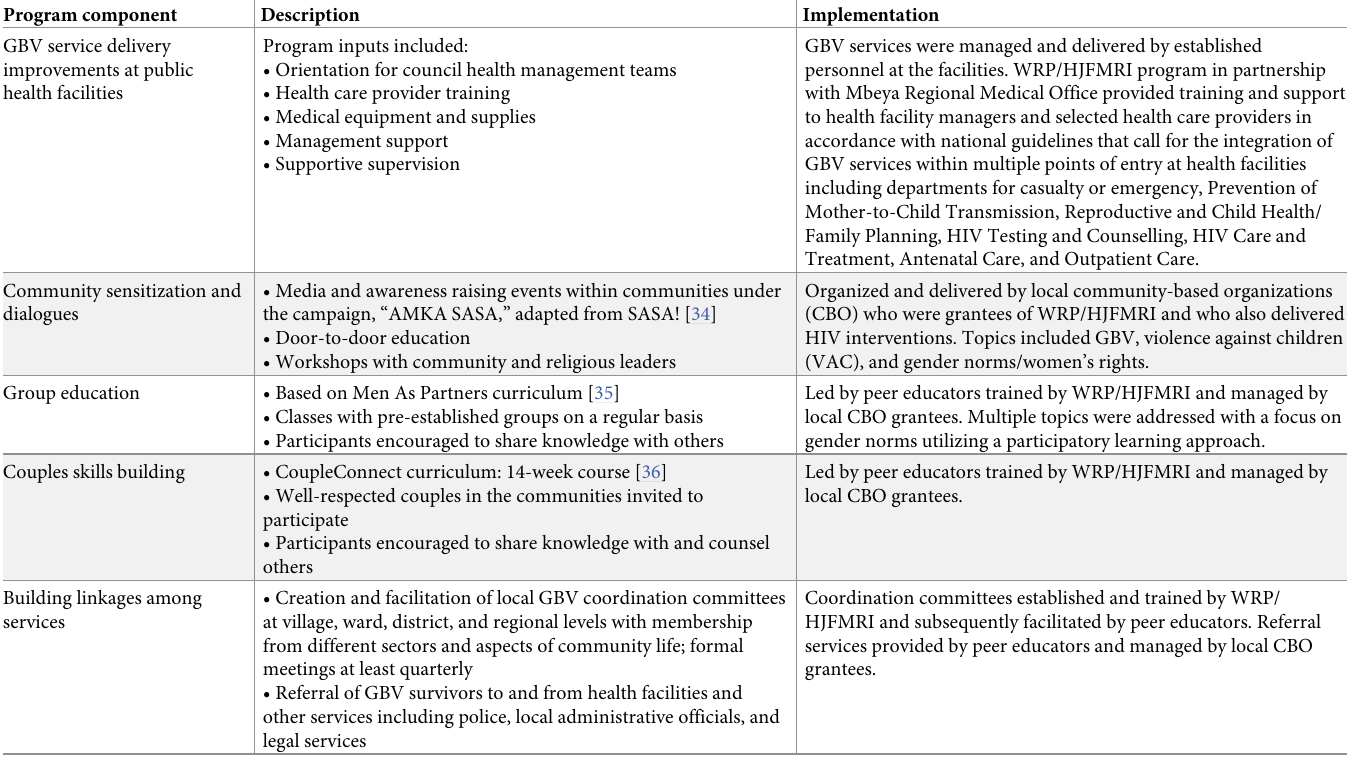
Table 1. WRP/HJFMRI GBV